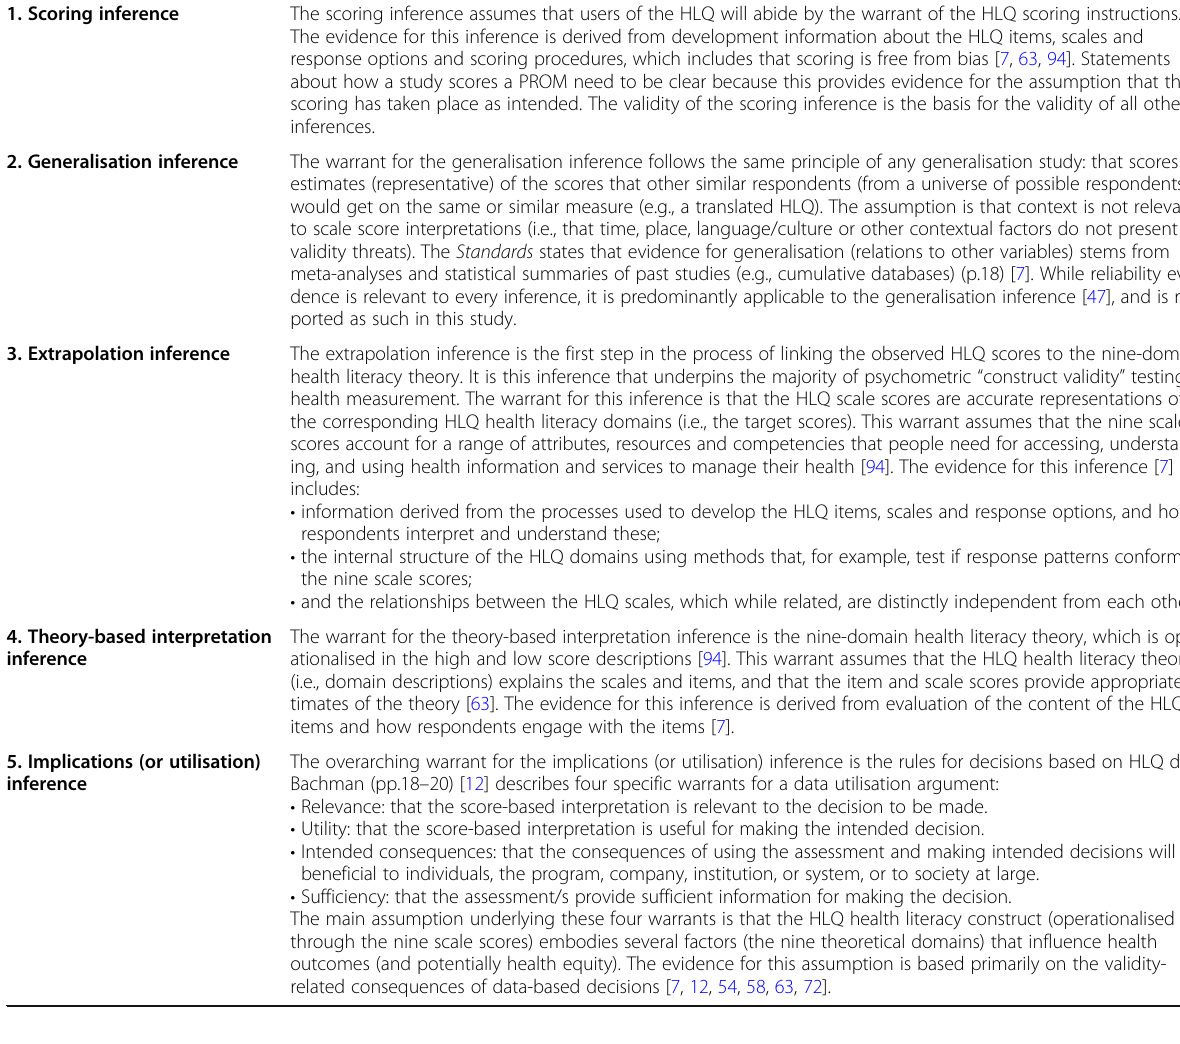
Table 2 The five inferences for measurement of theoretical constructs as related to the Health Literacy Questionnaire